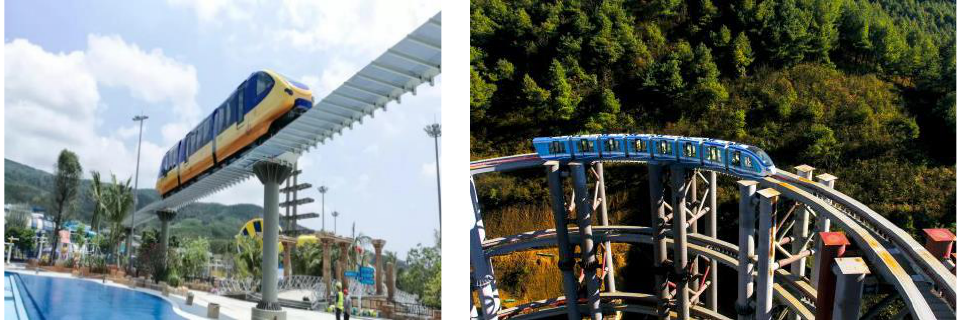
Figure 1. Single track monorail project ( left ) and double track monorail project ( right ) .